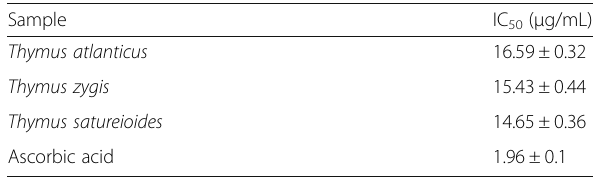
Table 1 Antioxidant activity of studied thymus species based on ABTS assay